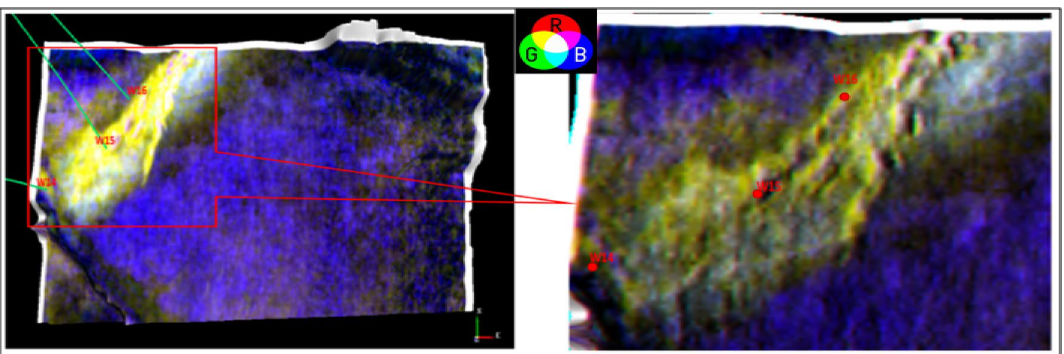
Fig. 13 RGB colour blended